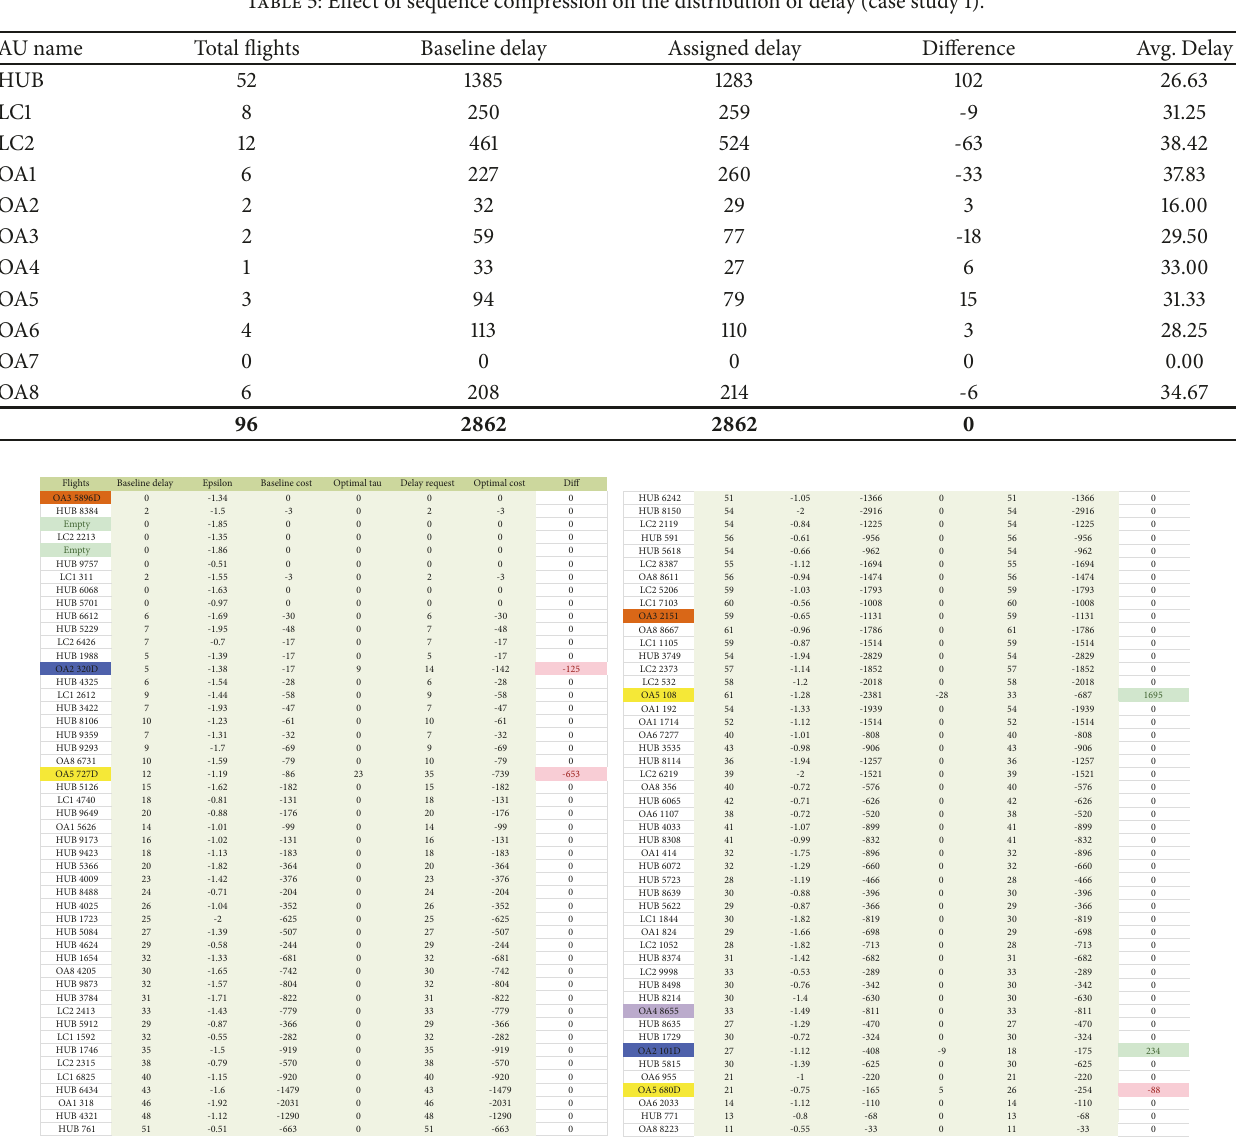
Figure 13: Schedule list with delay, costs, and optimal delay requested per flight (case study